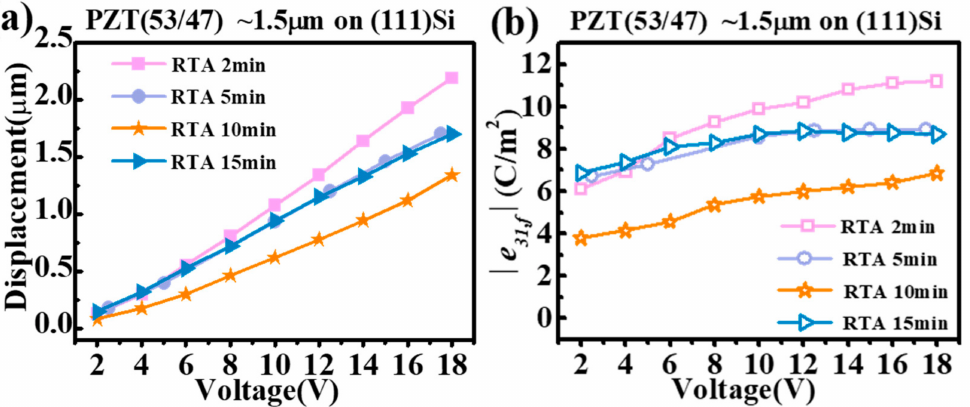
Figure 6. ( a , b ) Tip displacements and | e 31,f | transverse piezoelectric coefficients as functions of the applied AC voltage of the PZT film cantilever beams deposited on (111) Si and RTA annealed for 2–15